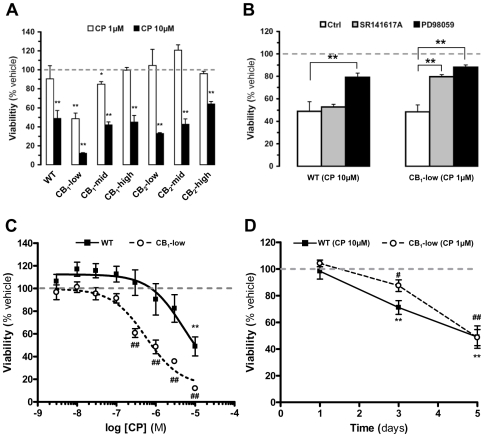
CP-55,940 kills DBT cells via cannabinoid receptor-dependent and -independent mechanisms.Wild-type (wt) DBT cells and DBT subclones stably expressing cannabinoid receptors were expanded in 24-well plates, incubated with CP-55,940 (CP) at either 1 µM (receptor mediated) or 10 µM (receptor independent), and cell viability was assessed by quantifying WST-1 conversion. (a) Five days after treatment, only CB1-low DBT cells showed significant sensitivity to CP at 1 µM, whereas all subclones were sensitive to CP at 10 µM. Data represent means±s.e.m. of 5–9 independent experiments in triplicate. (b) Only the pretreatment of CB1-low DBT cells with SR141617A (5 µM) prevented the CP-induced killing, whereas pretreatment with PD 98059 (PD, 10 µM) significantly reduced both the CP 1 µM and CP 10 µM induced toxicity in CB1-low and wild-type, respectively. Data represent means±s.e.m. of 3–5 independent experiments in triplicate. (c) Dose-response and (d) kinetics of CP-induced killing of wt and CB1-low DBT cells. Data represent means±s.e.m. of 3–9 independent experiments in triplicate. All results are expressed as % of WST-1 measurements in corresponding cells treated with vehicle (0.1% DMSO) for the indicated time point. In (a), (*) = p<0.05 and (**) = p<0.01 significantly different from the viability in the presence of vehicle only, ANOVA followed by Bonferroni's post-test. In (b), (**) = p<0.01 significantly different the viability after treatment with either 1 or 10 µM CP, ANOVA followed by Bonferroni's post-test. In (c), (**) and (##) = p<0.01 significantly different from the viability in the presence of vehicle only, ANOVA followed by Bonferroni's post-test. In (d), (#) = p<0.05, and (**) and (##) = p<0.01 significantly different from the viability in the presence of vehicle only at corresponding time point, ANOVA followed by Bonferroni's post-test.